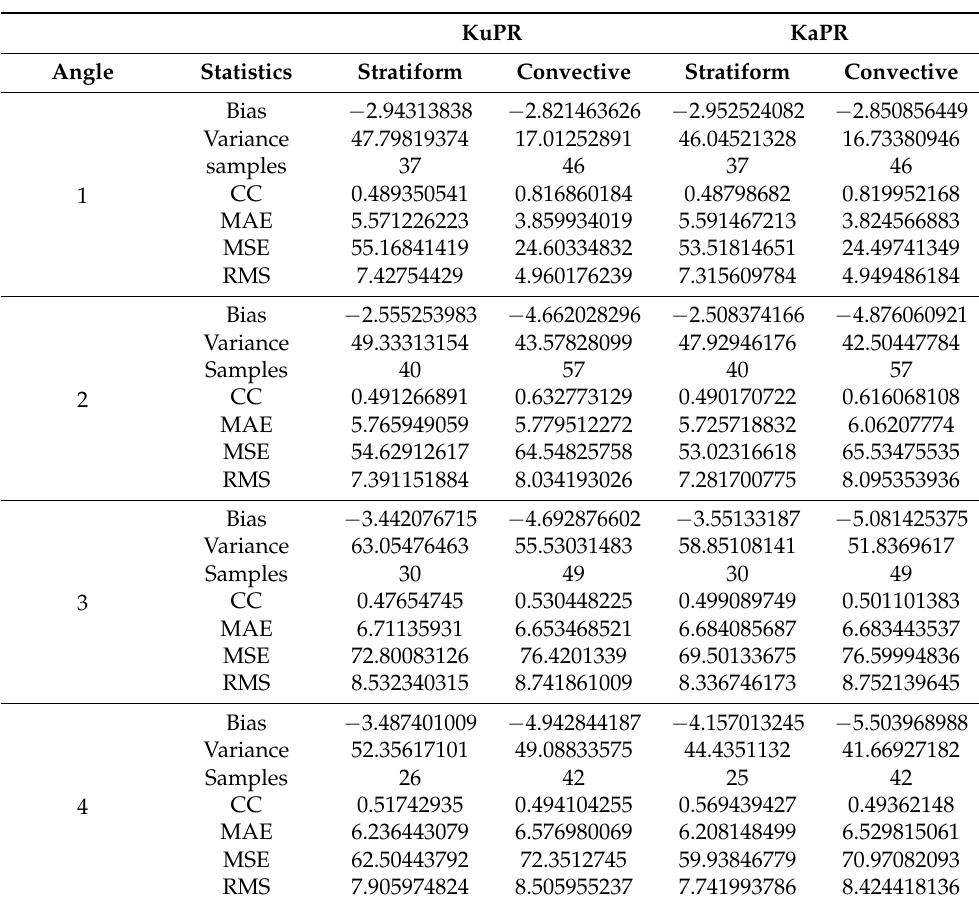
Table 3. Statistical results for Hurricane